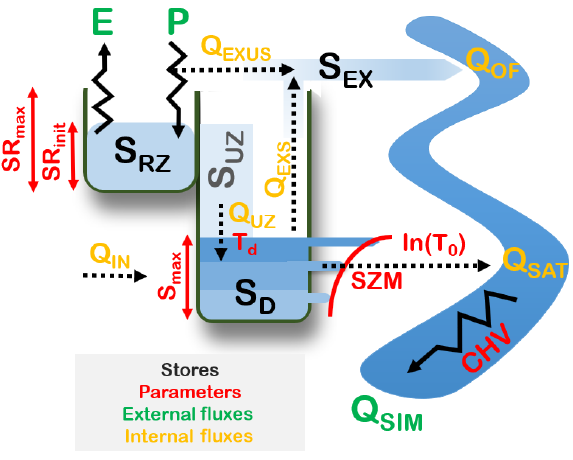
Figure 3. Simplified conceptual diagram of the model structure cur- rently implemented in DECIPHeR. All scientific notations are de- scribed in Table